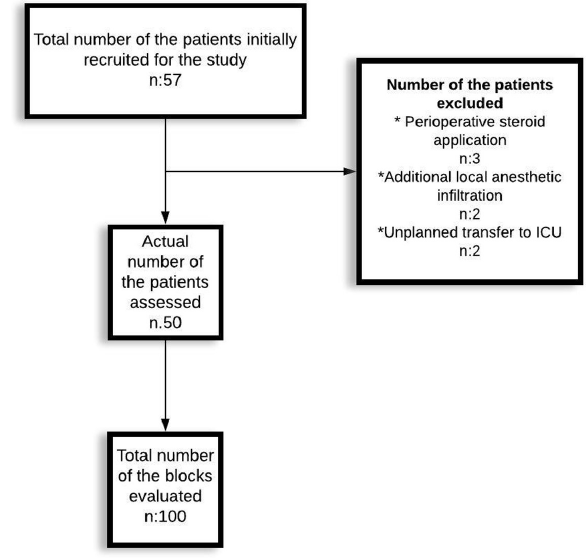
Figure 1. Strobe flow chart. ESPB, erector spinae plane block.